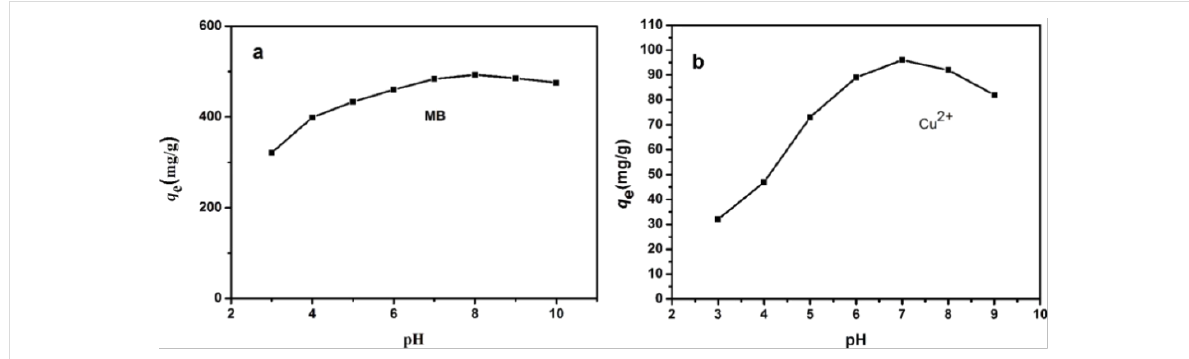
Figure 4: Effect of solution pH value on the adsorption of (a) MB ( C 0 = 500 mg/L) and (b) Cu 2+ ( C 0 = 100 mg/L) on Lys-GO.